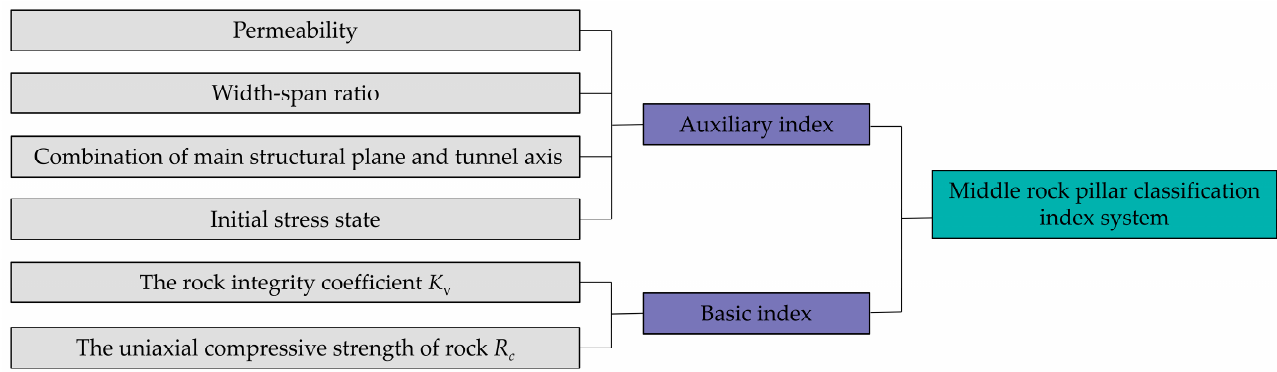
Figure 2. Proposed middle rock pillar classification index system. Table 6. Score of middle rock pillar integrity.